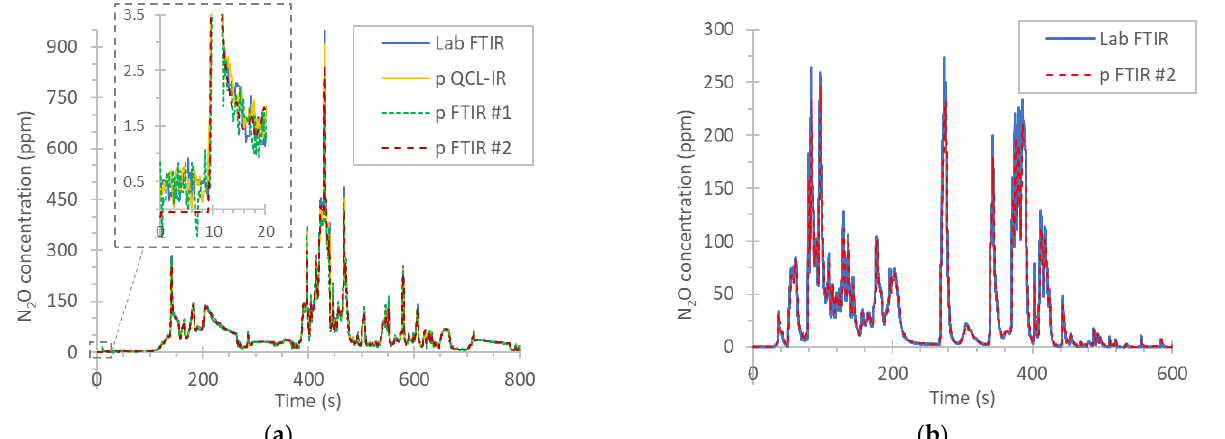
Figure 8. Real time N 2 O concentrations over the first minutes of cold start WHTCs: ( a ) diesel engine D1; ( b ) CNG engine. CNG = compressed natural gas engine; FTIR = Fourier transform infrared; p = portable; PEMS = portable emissions measurement system; QCL-IR = quantum cascade laser infrared; WHTC = world harmonized transient cycle.